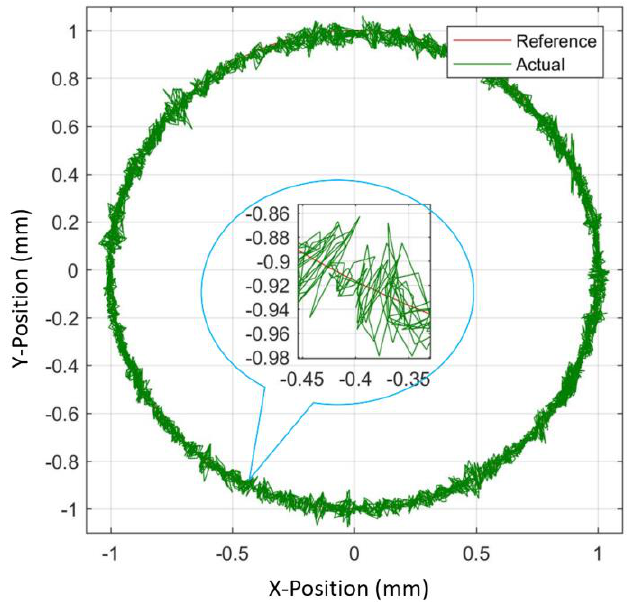
Figure 22. Experimental demonstration of the position estimator algorithm for tracking a circle with a diameter of 2 mm.